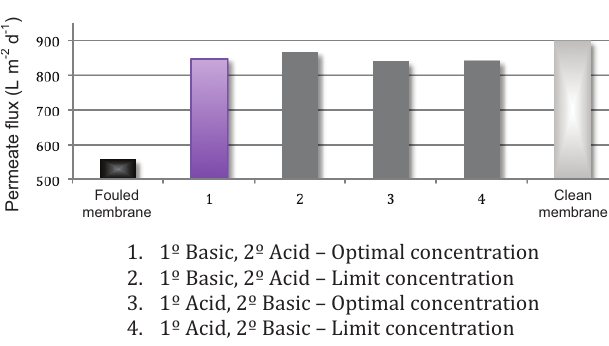
1. 1º Basic, 2º Acid – Optimal concentration 2. 1º Basic, 2º Acid – Limit concentration 3. 1º Acid, 2º Basic – Optimal concentration 4. 1º Acid, 2º Basic – Limit concentration Fig. 6 – Evolution of permeate flux in sequential cleaning